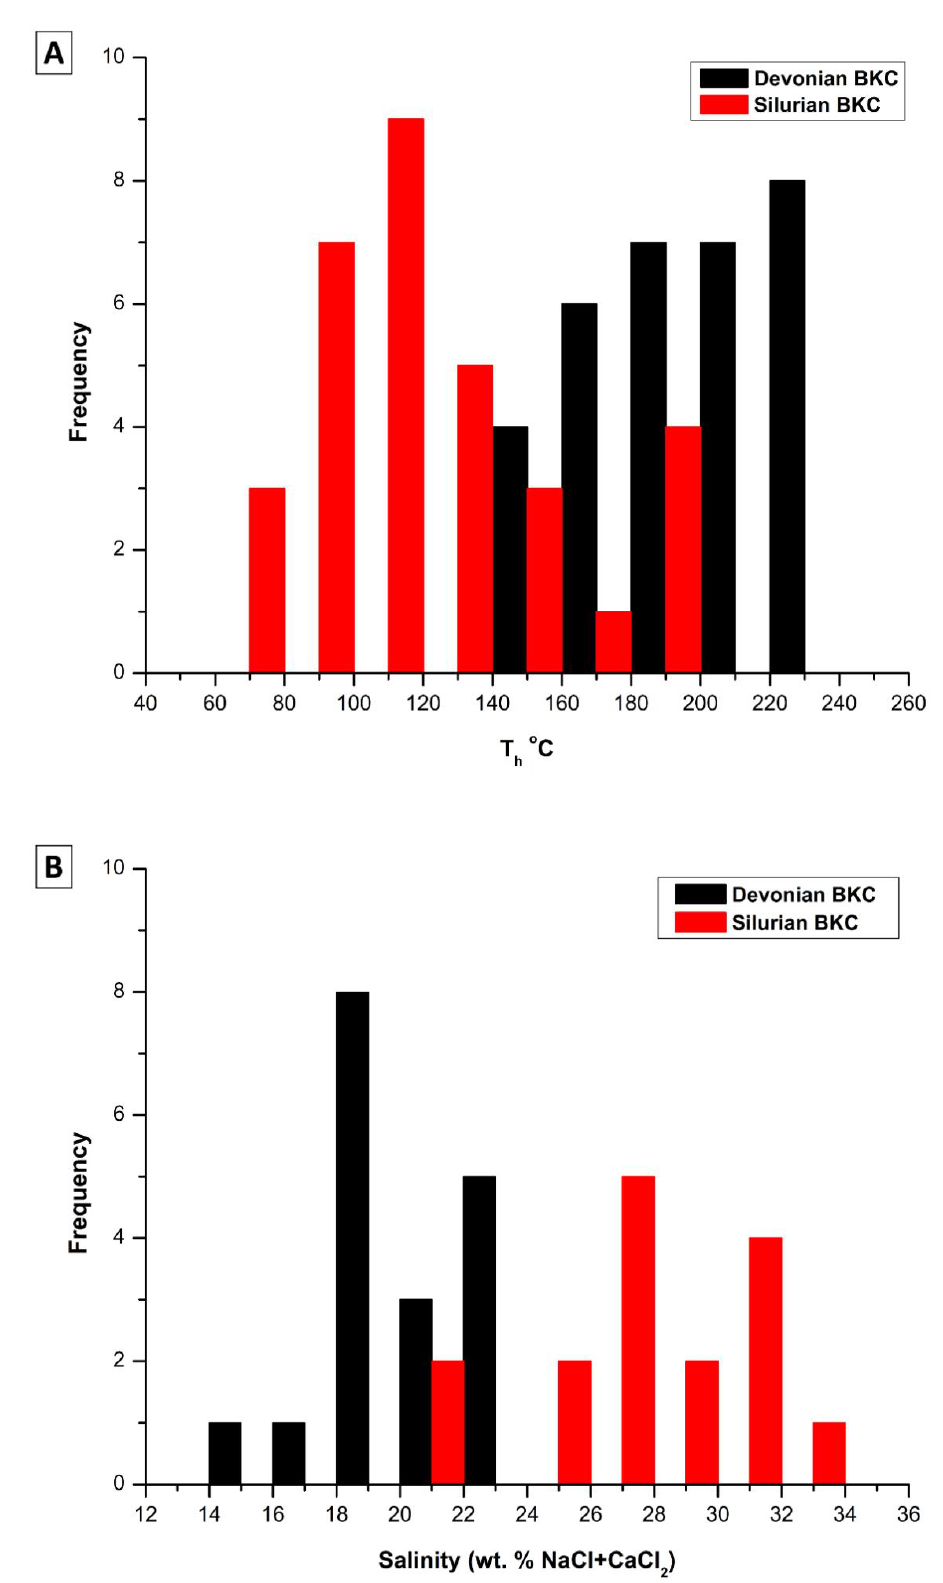
Figure 16. Histogram plots of ( A ) homogenization temperature and ( B ) salinity for calcite cement (BKC) in Silurian and Devonian formations.